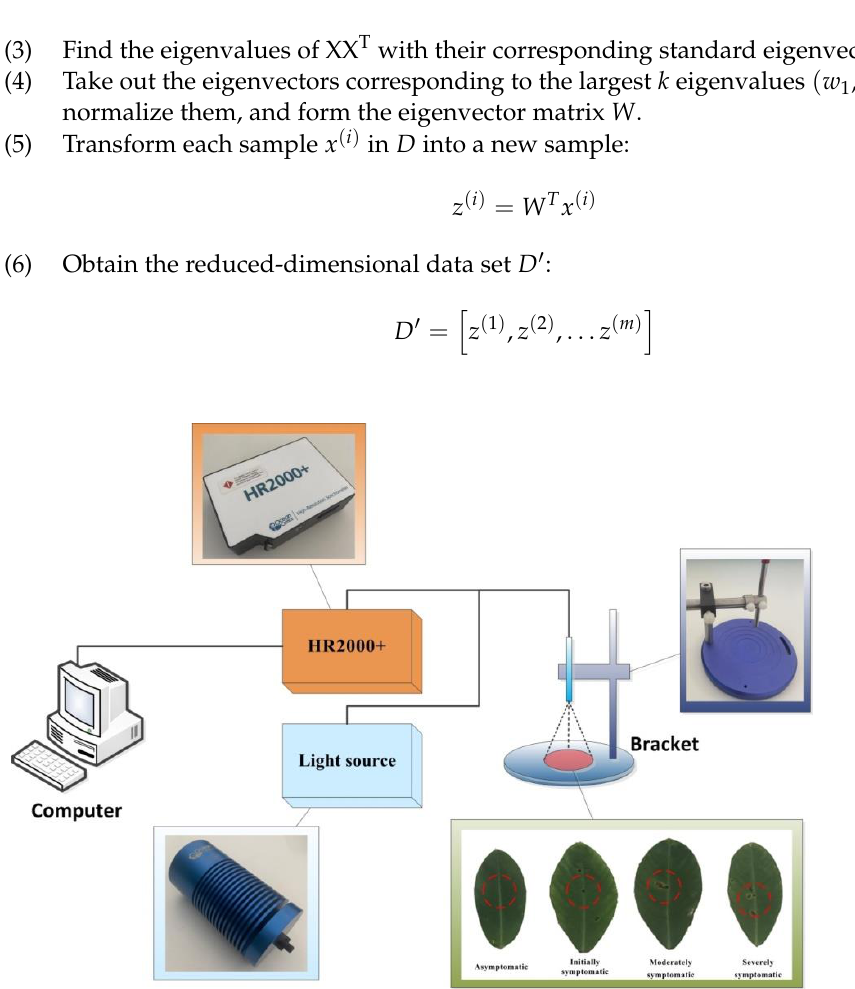
Figure 2. Collection equipment and leaf samples.